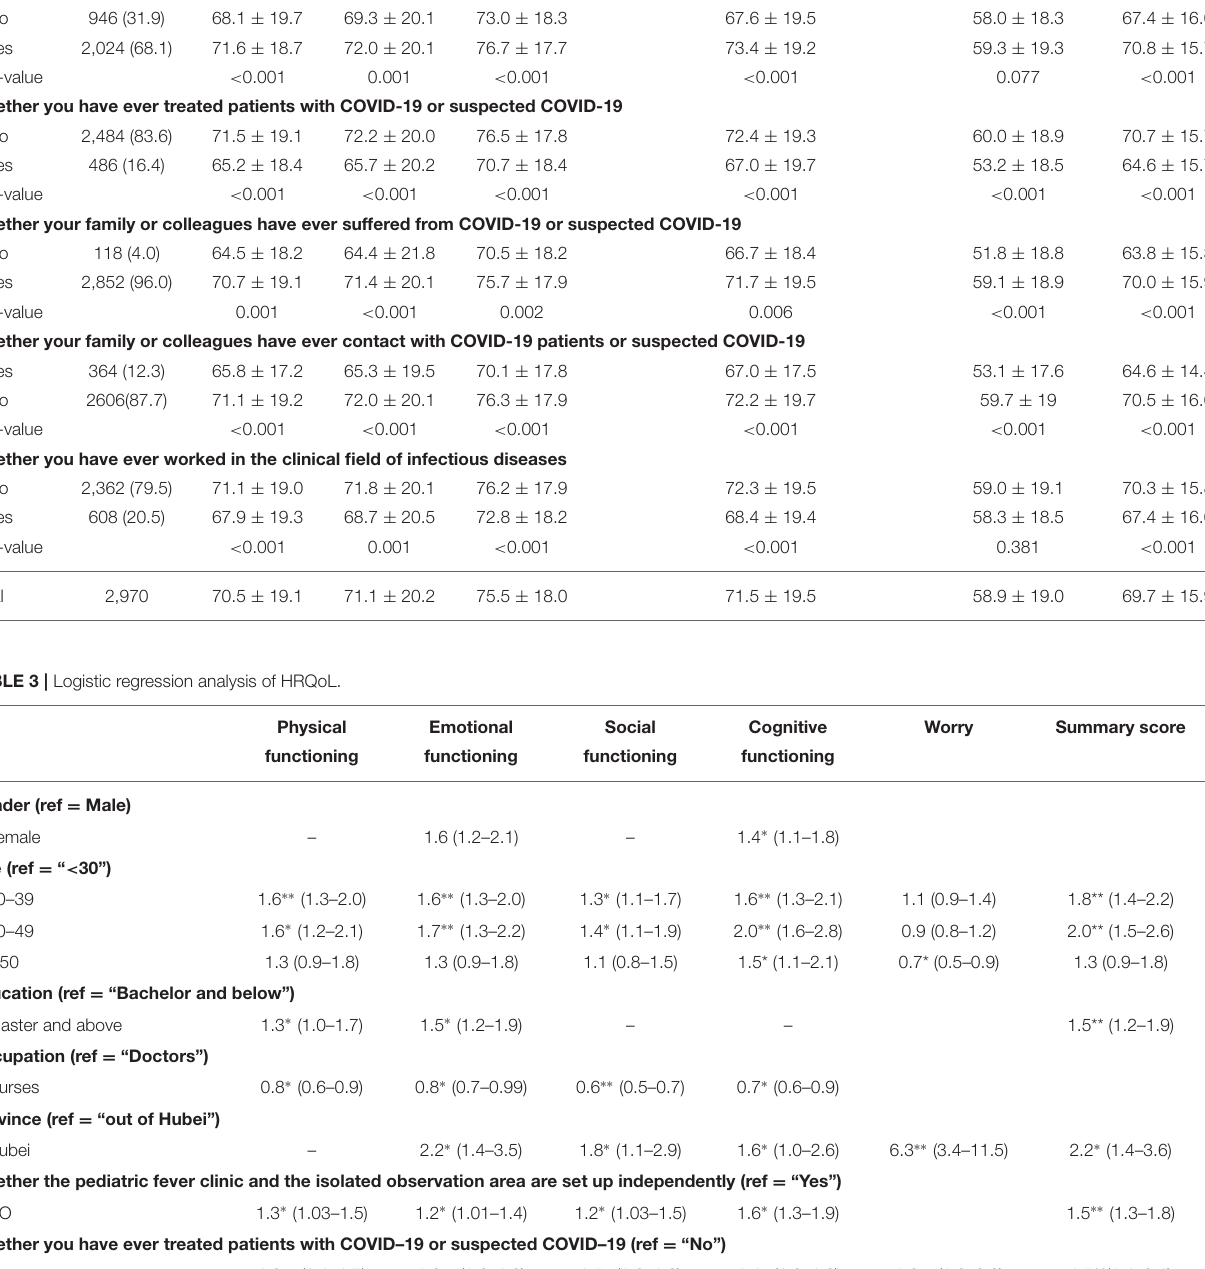
Worry Summary score